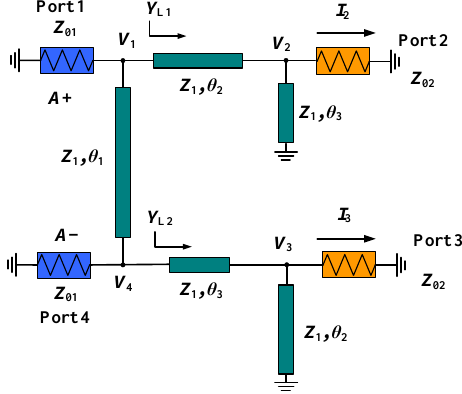
Figure 2. Transmission part of the proposed BTU arbitrary power divider.